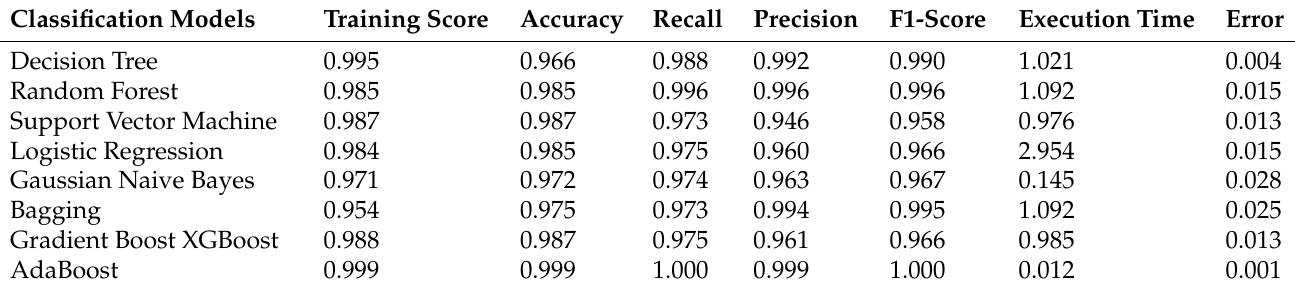
Table 12. Experimental Results.